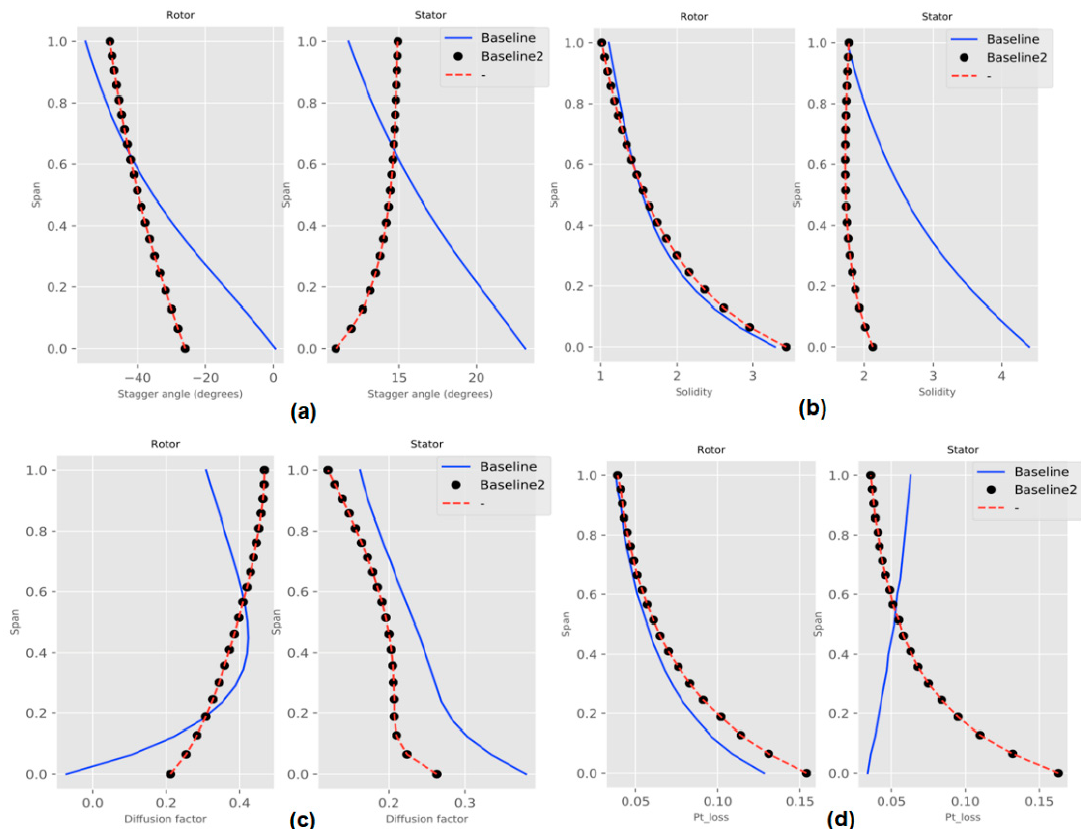
Figure 21. Rotor and stator properties for the improved baseline of the BLI fan. Stagger angles are compared in (a), solidity in (b), diffusion factor in (c) and total pressure loss in (d).